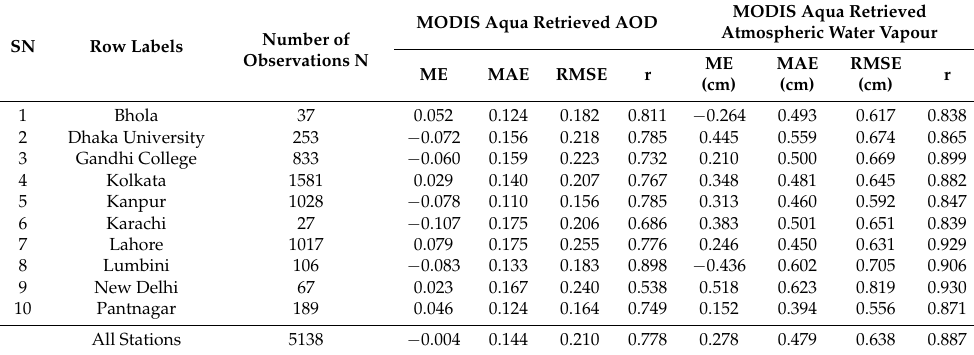
Table 5. Evaluation of Moderate Resolution Imaging Spectroradiometer (MODIS) Aqua derived AOD and atmospheric water vapour against AERONET measured AOD and atmospheric water vapour for the IGP stations. Number of Observations